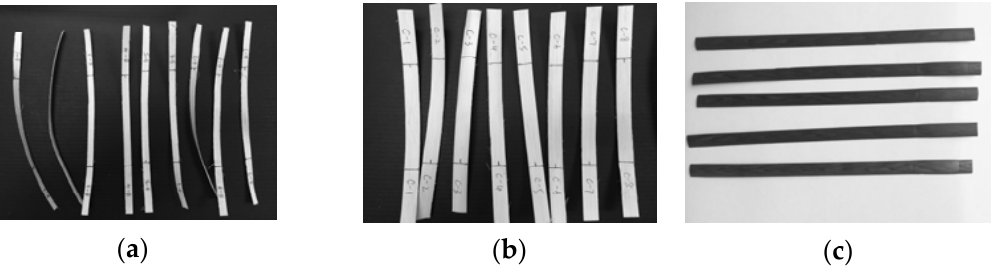
Figure 3. Testing strips of bast ( a ), core ( b ), and synthetic ( c ) rattan materials.